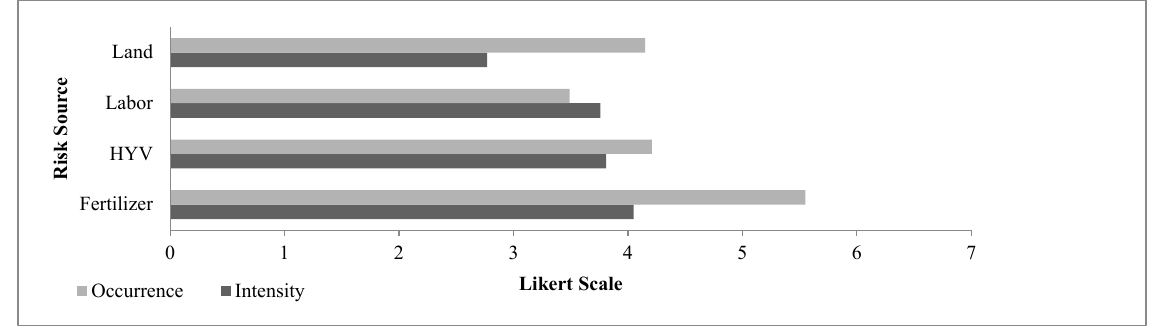
Figure 2. Input affordability risk perceptions.